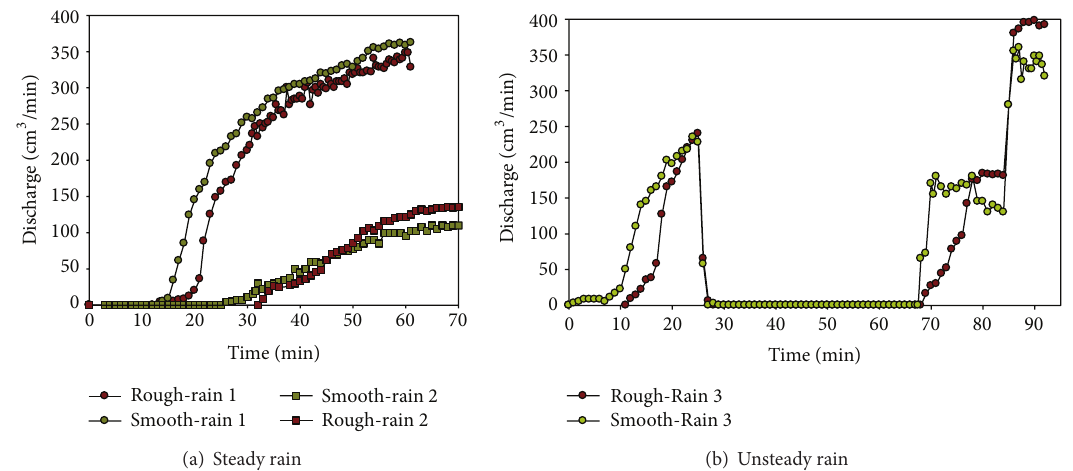
Figure 5: Observed hydrographs of the laboratory rough and smooth surfaces for two steady rainfall events (Rain 1: 5.95 cm/hr and Rain 2: 3.54 cm/hr) and one unsteady rainfall event (Rain 3: 5.95-1.16-3.54-5.95